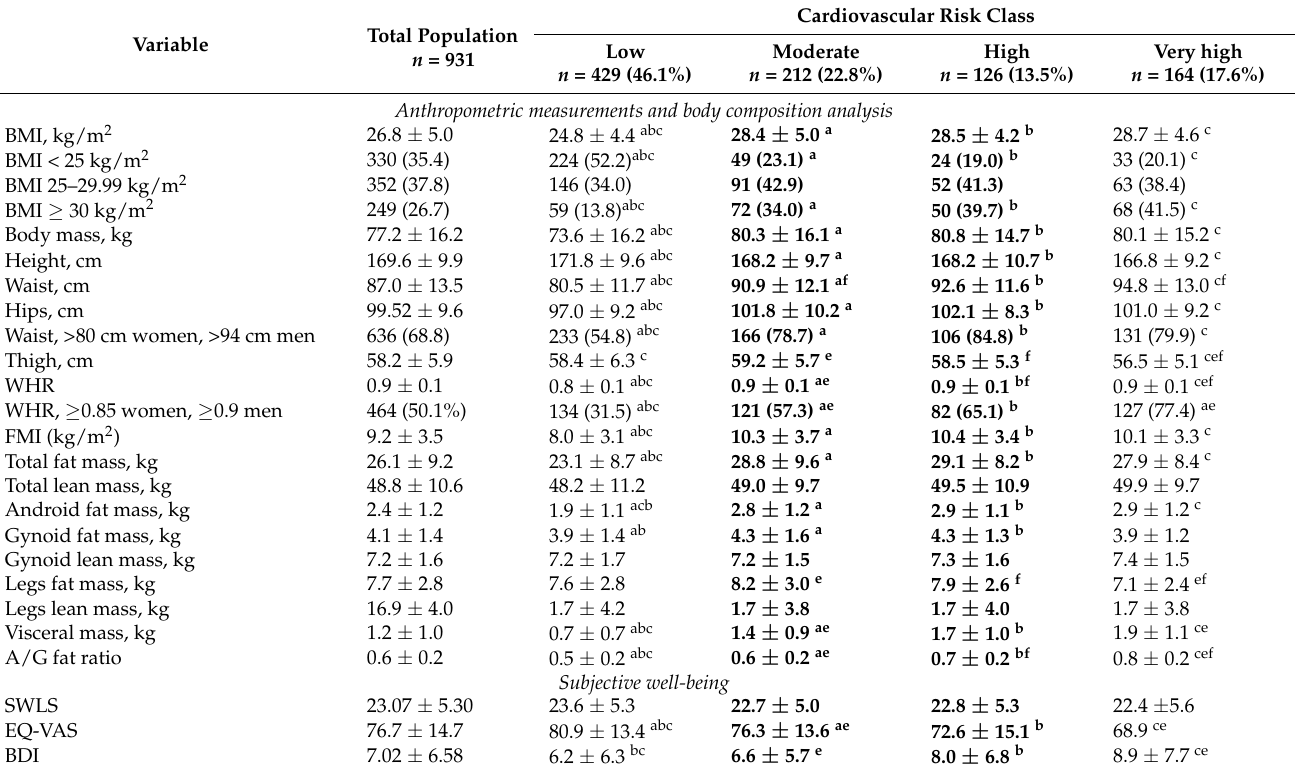
Table 2. Characteristics of the total population and of subgroup according cardiovascular risk and comparisons variables between subgroups (anthropometric measurements, body composition analysis, subjective